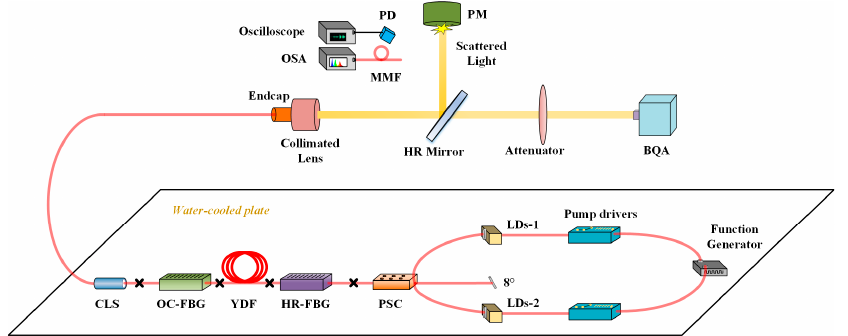
Figure 1. Experimental setup containing fi ber laser oscillator and pump modulation devices. (LDs: Laser diodes; PSC: Pump-signal combiner; HR: High re fl ection; FBG: Fiber Bragg grating; OC: Out- put coupler; YDF: Y tt erbium-doped fi ber; CLS: Cladding light stripper; PD: Photodiode; OSA: Op- tical spectrum analyzer; MMF: Multimode fi ber; PM: Power meter; BQA: Beam quality